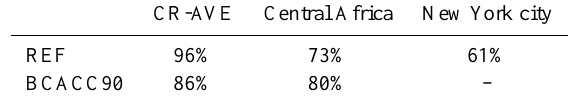
Table 6. Number fraction of internally mixed BC at surface level in the simulations REF and BCACC90 over the region of the CR- AVE campaign, central Africa and the New York City area. These three regions are characterized by low BC emissions, biomass burn- ing (accumulation mode BC) and anthropogenic emissions (Aitken mode BC), respectively. No value is given for BCACC90 over New York City since BCACC90 does not account for Aitken mode BC emissions. CR-AVE